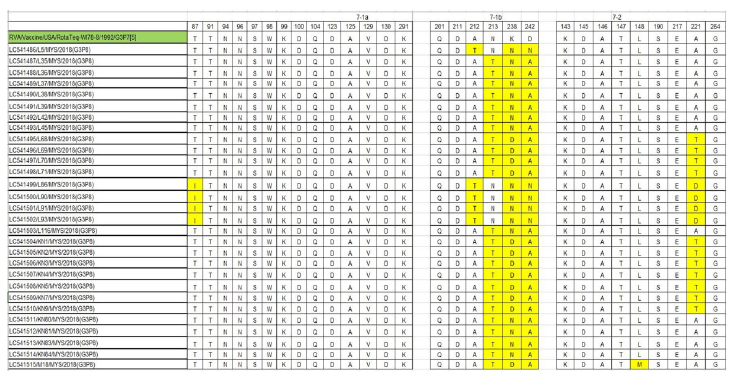
Fig 9. Comparison of the antigenic residues of VP7 present in genotype G3 strains of RotaTeq and the strains circulating in Sabah, Malaysia. The respective antigenic epitopes are shown above the residue numbers. The amino acid residues in the Sabahan strains that differed from those in the vaccine strains are highlighted in yellow.